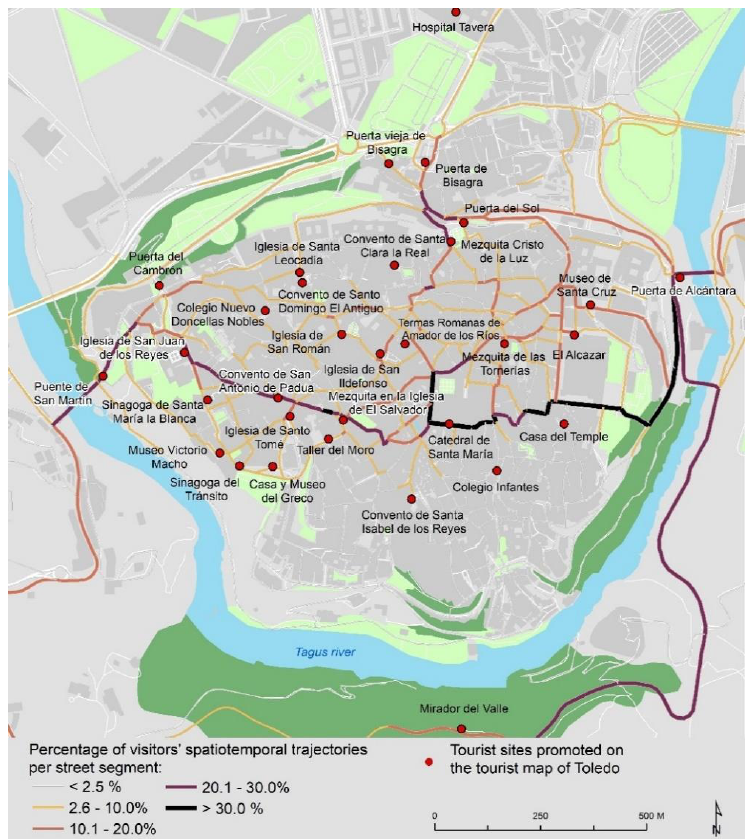
Figure 8. Percentage of visitor STTs per street segment and location of the tourist attractions promoted on the official tourist map of Toledo. Source: Authors’ own elaboration.